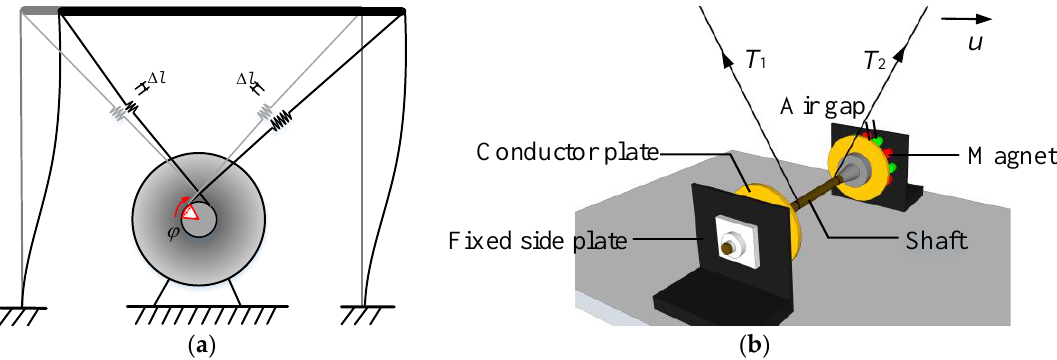
Figure 1. A single-degree-of-freedom (SDOF) structure with a CBIS: ( a ) structure with a CBIS and ( b ) detail of a CBIS. Note that the conductor plates serve as